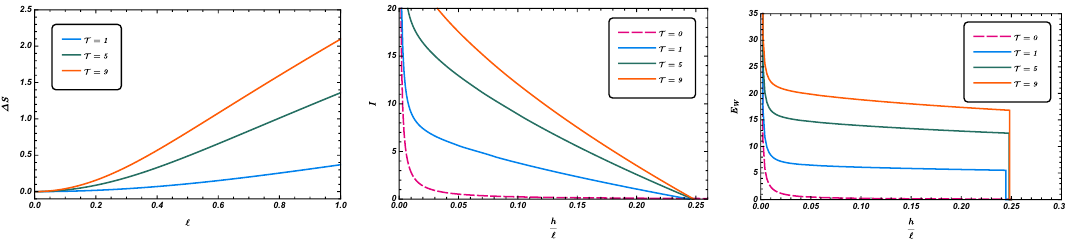
Figure 4 . Subtracted HEE (left), HMI (middle) and EoP (right) as functions of the width and separation between subregions for different values of T in d = 3